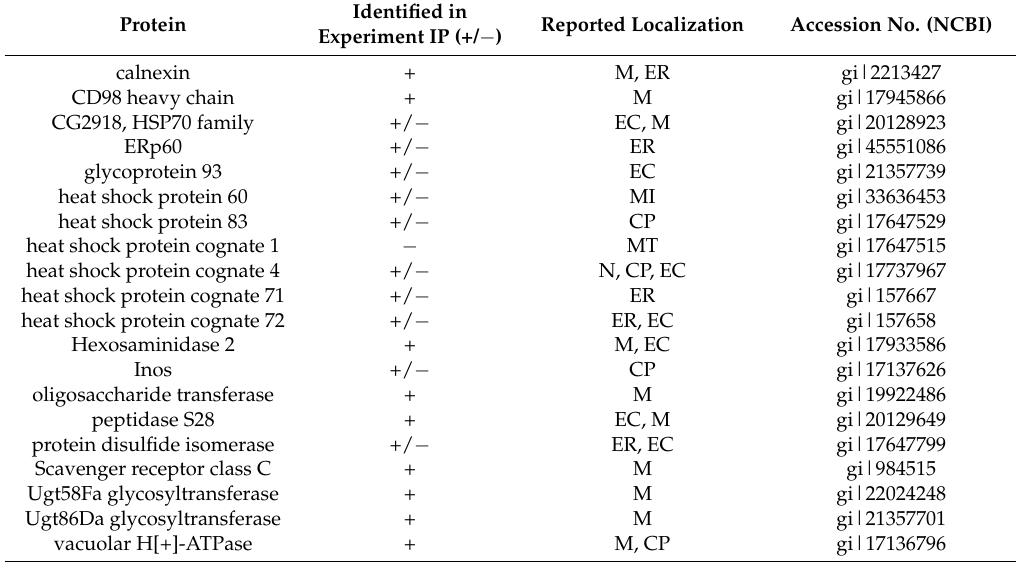
(Table S1). Other proteins with high Mascot scores, like bacterial effector Vopl or actin, correspond to co-precipitated species that potentially are bound by the chaperones. Table 1. Potentially O -glycosylated proteins which were highly modified with GlcA after overexpression of dGlcAT-P in S2-cells. Proteins within a mass range of 60–70 kDa were intensively stained by mAb 114-2G11-A and therefore excised from an SDS-gel and identified by LC-ESI-MS/MS (experiment “gel”) The same lysates was immunoprecipitated with mAb 114-2G11-A and identified likewise (experiment “IP”). (ER: endoplasmatic reticulum, EC: extracellular, N: nucleus, CP: